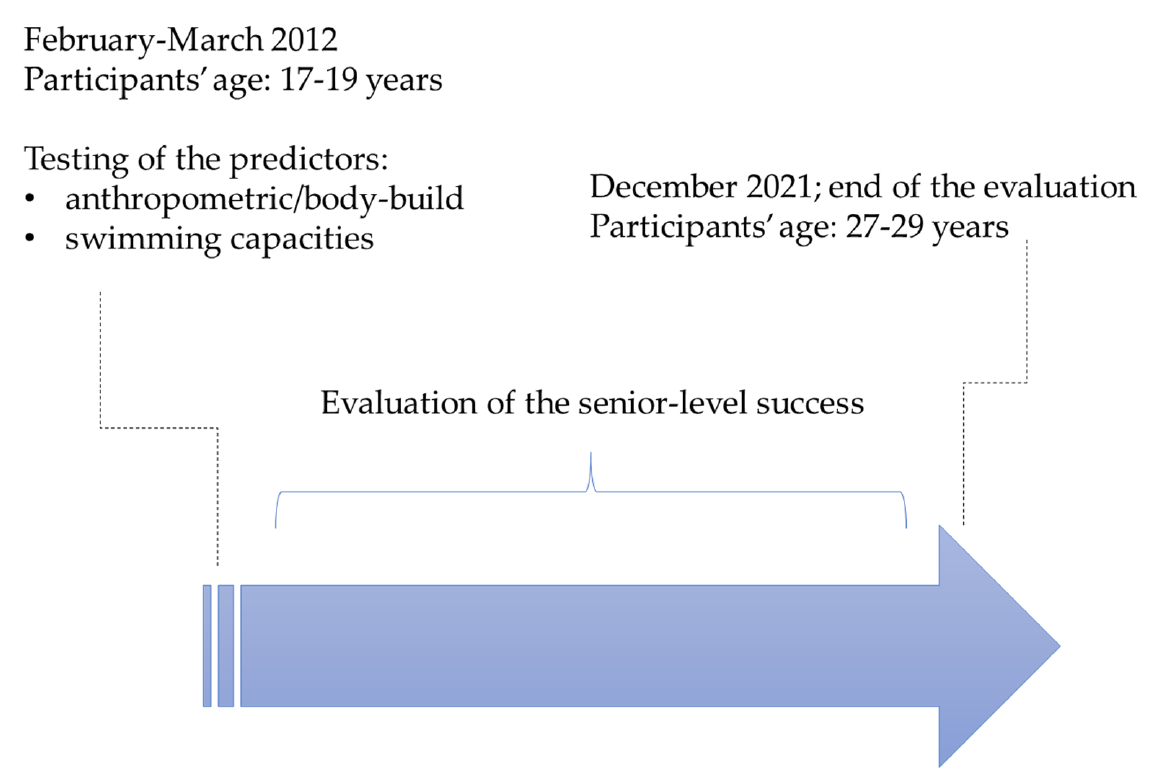
Figure 1. Study design.